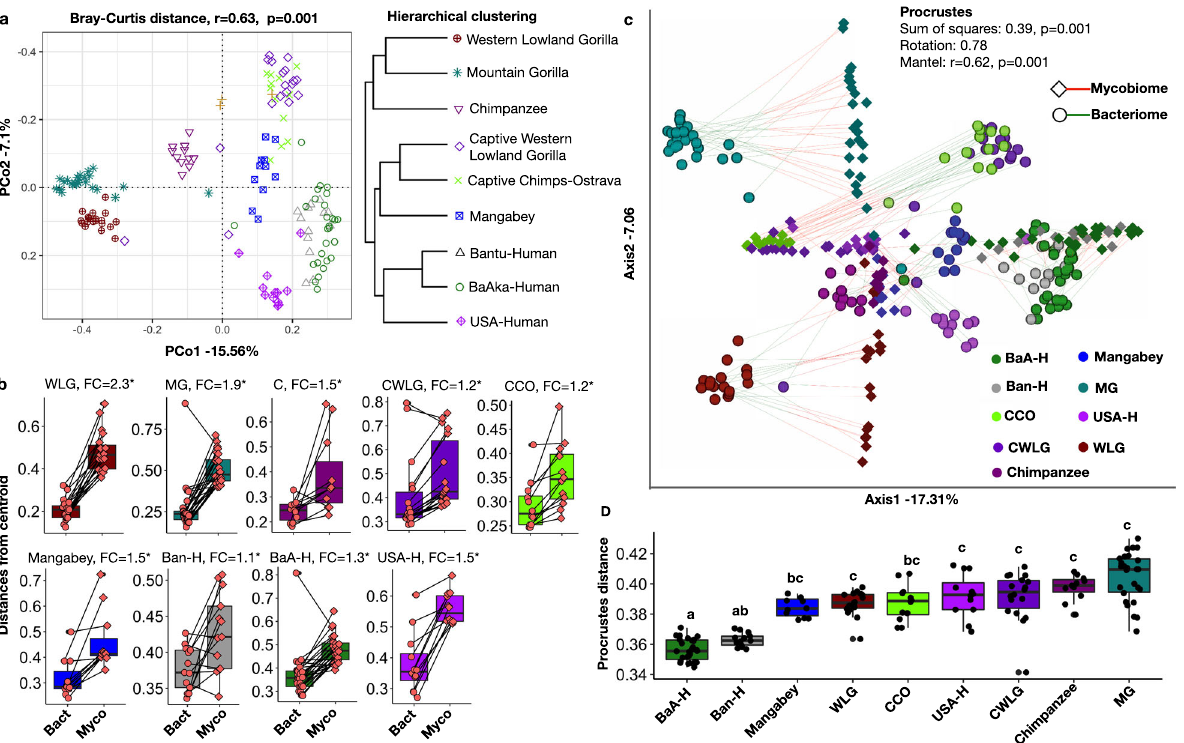
Fig. 3 Combined gut bacteriome and mycobiome community composition differ across different primate species. a Principal coordinate analysis based on Bray-Curtis distances showing signi fi cant differences in combined bacteriome and mycobiome community composition across different primate groups. Each symbol represents the combined bacteriome and mycobiome composition at the ASV level in fecal samples of an individual primate species. A Bray-Curtis distance dendrogram (hierarchical clustering, method = average) based on mean abundances . b Distances to centroid show higher inter-individual variations in mycobiome community composition as compared to bacteriome across different primate groups. Fold changes along with the statistical signi fi cance based on wilcoxon rank-sum tests ( p < 0.05, highlighted by *) are provided at the top of each boxplot ( c ) Correspondence between bacteriome and mycobiome composition as shown by Procrustes analysis on Bray-Curtis distances (Protest corr = 0.78, p = 0.001 and mantel test, r = 0.63, p = 0.001). D Procrustes distances between bacteriome and mycobiome composition in each primate group show greater correspondence in traditional human populations. The identi fi ers used for primate groups are US-H: US-Human, CCO: Captive Chimpanzee-Ostrava, CWLG: Captive Western Lowland Gorilla, MG: Mountain Gorilla, Ban-H: Bantu-Human, BaA-H: BaAka-Human, and WLG: Western Lowland Gorilla. In boxplots , center values indicate the median; bounds of box represents lower/upper quartiles; whiskers show inner